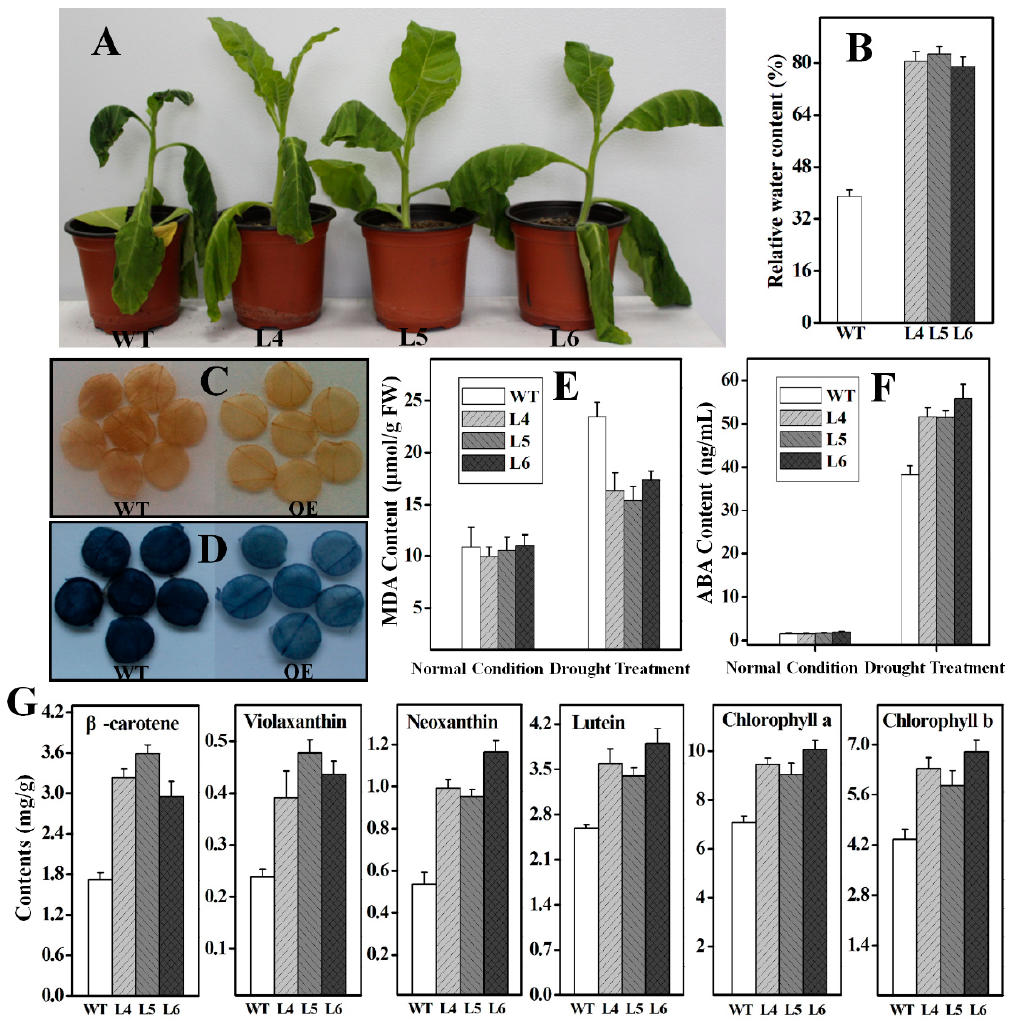
Figure 9. Effects of drought treatment on T 1 generation Nt β -LCY1 OE transgenic plants. ( A ) Phenotypes of WT and Nt β -LCY1 OE plants after three weeks of drought stress; ( B ) Relative water content in leaves of WT and OE plants after drought stress; ( C , D ) 3,3,-diaminobenzidine (DAB) ( C ) and nitro blue tetrazolium (NBT) ( D ) staining for evaluation the accumulation of H 2 O 2 and O 2 − in WT and OE plants after drought stress; ( E , F ) Malondialdehyde (MDA) and abscisic acid (ABA) content in leaves of WT and OE plants treated with or without drought stress; ( G ) Carotenoid and chlorophyll content in WT and Nt β -LCY1 OE transgenic plants after three weeks of drought treatment. L4–L6, three lines of Nt β -LCY1 OE transgenic plants. Error bars represent standard deviation ( n = 6). The data presented here are representative of three independent experiments.